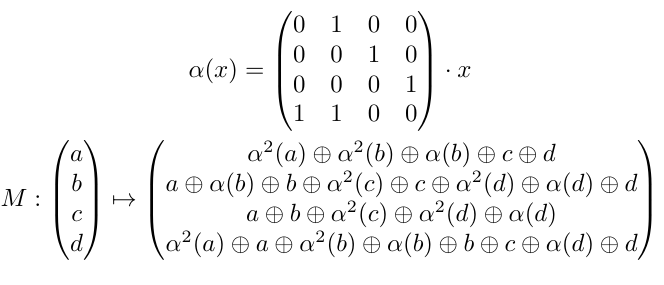
Figure 2: Saturnin ’s M transformation.